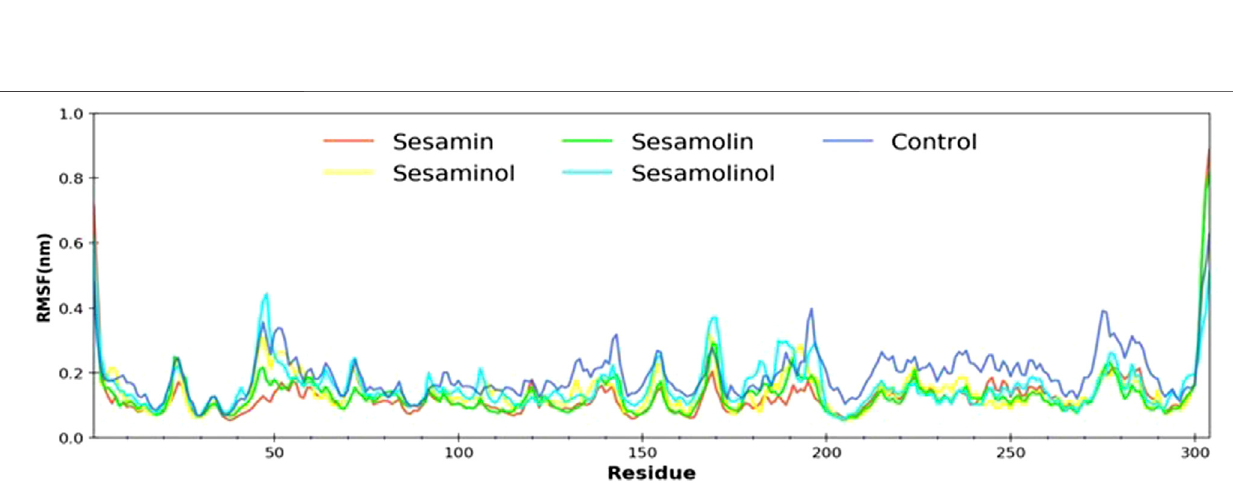
Frontiers in Chemistry |